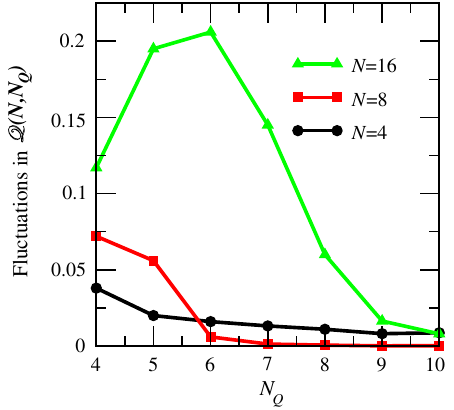
FIG. 4. We plot the fluctuations in time for Q as a function of N N ¼ L ¼ 4 ; 8 , and 16 for a quench in a c ¼ 10 gas from a Q for parabolic potential of strength m ω 2 0 L 2 = 2 E F ¼ 2 . 33 to a cosine of x Þ ¼ 0 . 26 E 2 π x=L Þ . We do so using the amplitude V F cos ð cos ð charges constructed at c ¼ ∞ , as discussed in Appendix B, as a partial demonstration that such charges work well at finite c .